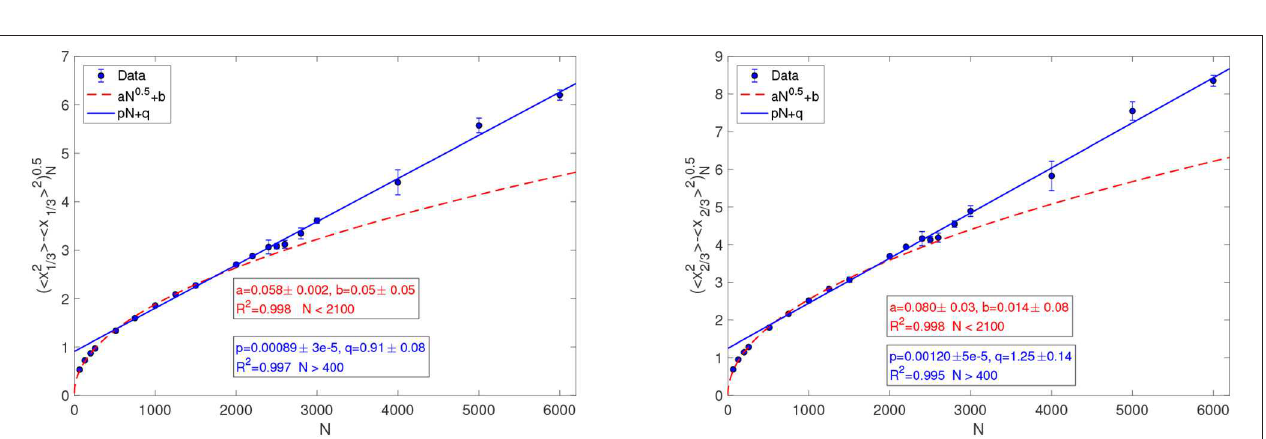
FIGURE 3 | (Left) Dependence on N of the standard deviations of the vibrations of particles at 1/3 of the chain. (Right) Dependence on N of the standard deviations of the vibrations at 2/3 of the chain. In both cases, a square root and a linear fit are drawn. The square root fit holds at small N . At large N the linear fit takes over. In both panels N ranges from 64 to 6000. Particles motions look more like some kind of convection rather than like microscopic lattice vibrations.